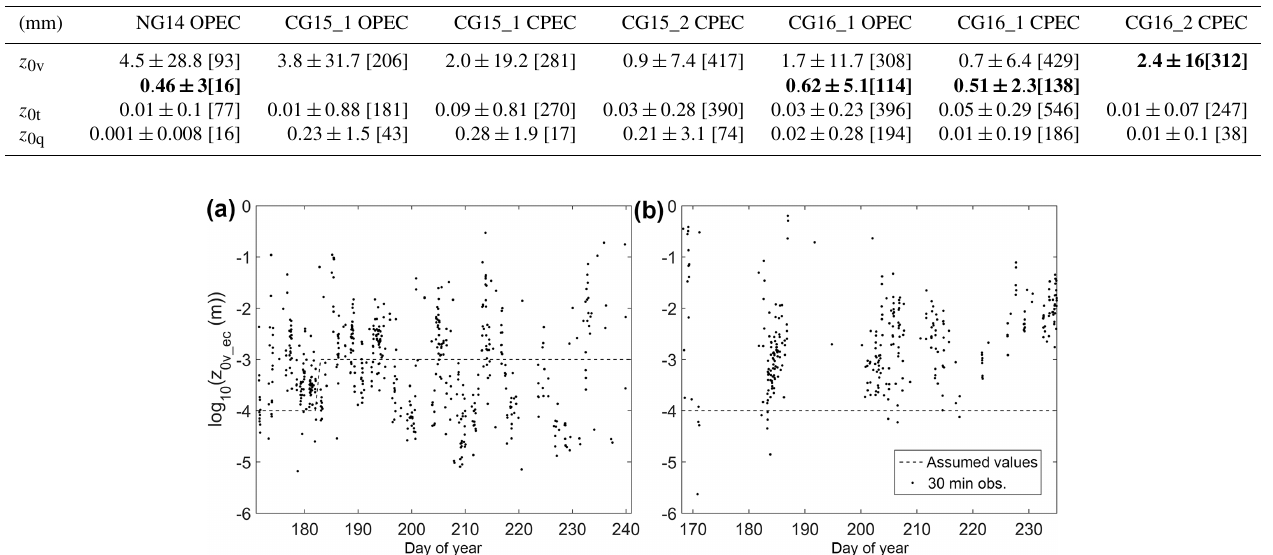
Table 4. Seasonal geometric means of the EC-derived roughness length values ( ± σ ) from the open- and closed-path systems for each station site. z 0v_ec values for periods with a snow-covered surface are written in bold font. The number of 30min periods available for roughness estimation (after filtering) is presented in square brackets.